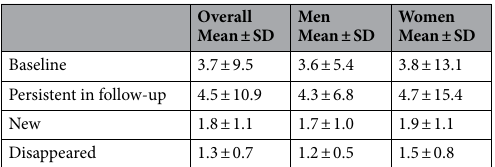
Table 3. Mean number of cysts during both time points; SD = standard deviation.